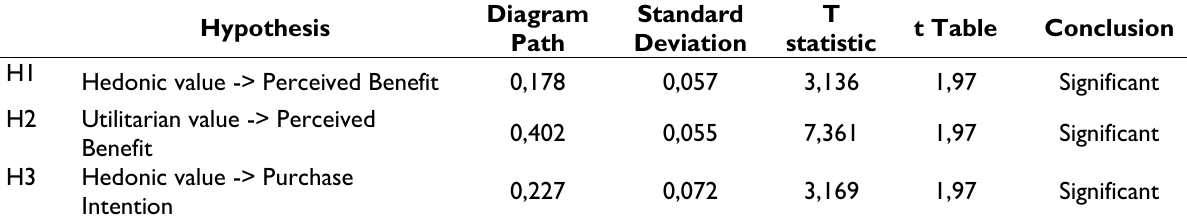
Table 5. Hypothesis Testing